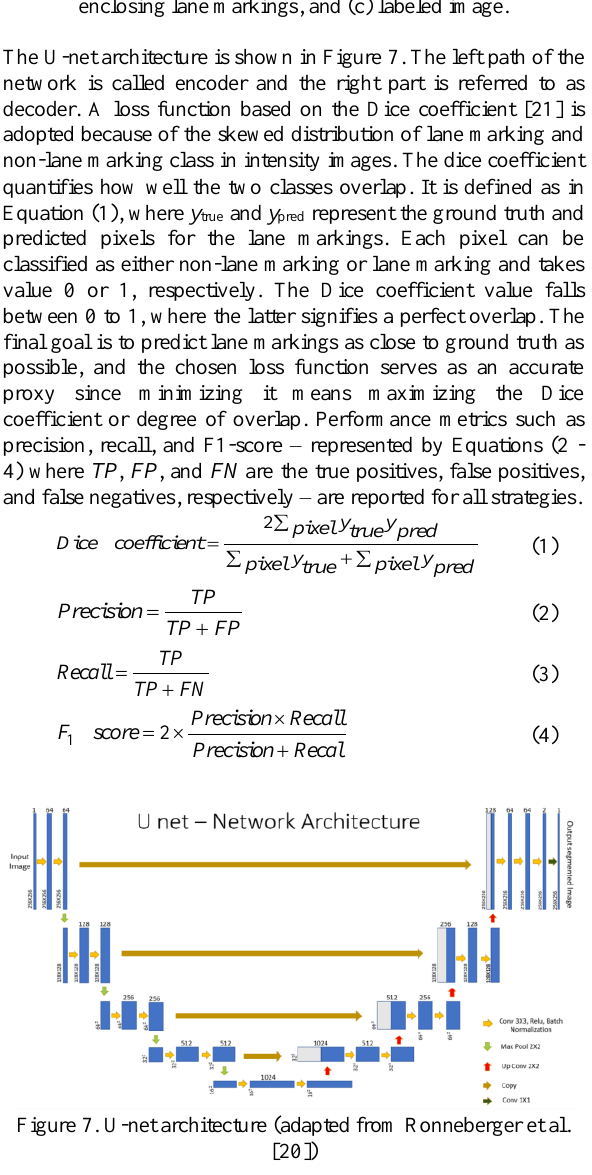
Figure 6. Automatic label generation: (a) normalized intensity thresholding lane markings, (b) bounding boxes (in red) enclosing lane markings, and (c) labeled image.